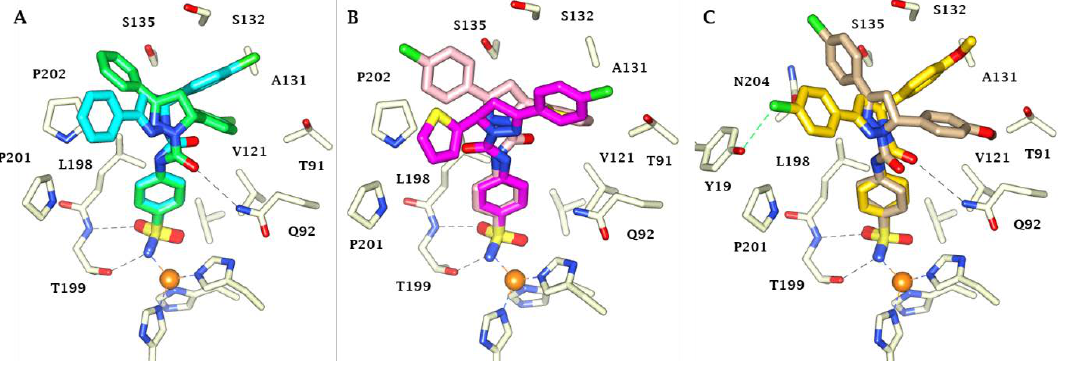
Table 2. Docking score (Glide) of the predicted poses of (R) - and (S)- enantiomers of 5–25 and AAZ